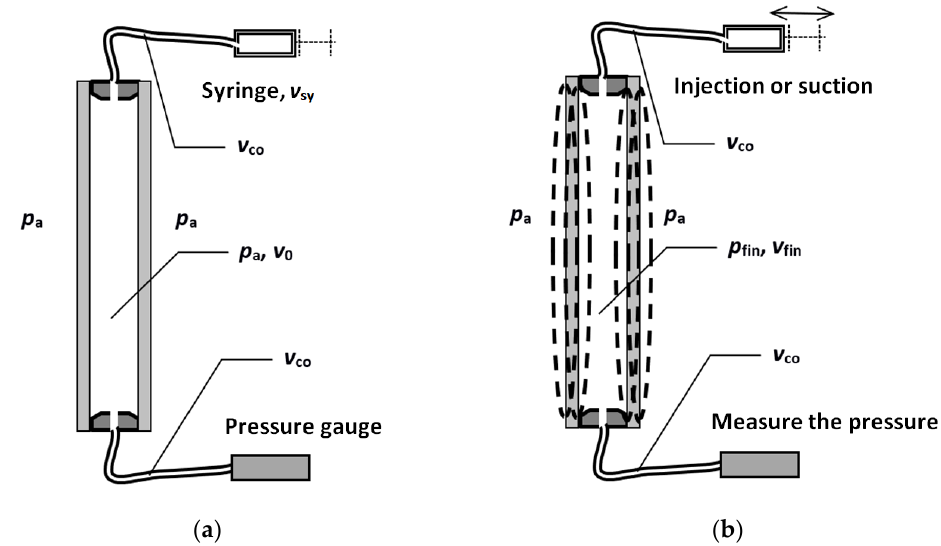
Figure 3. Test scheme: ( a ) initial parameters; ( b ) final parameters.